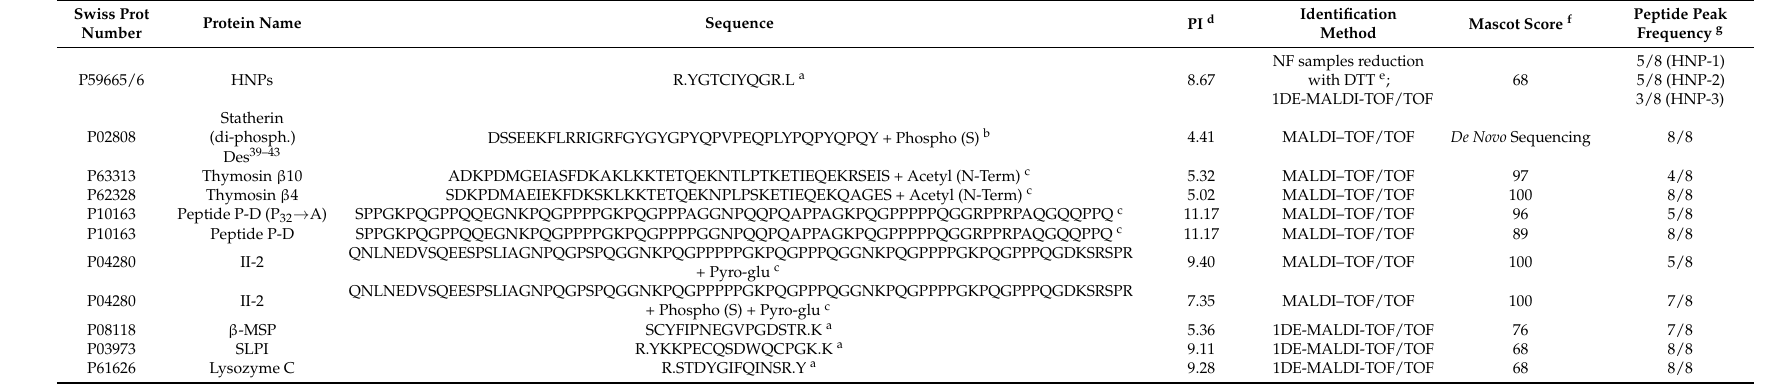
Table 1. NF proteins identified using MALDI-TOF/TOF